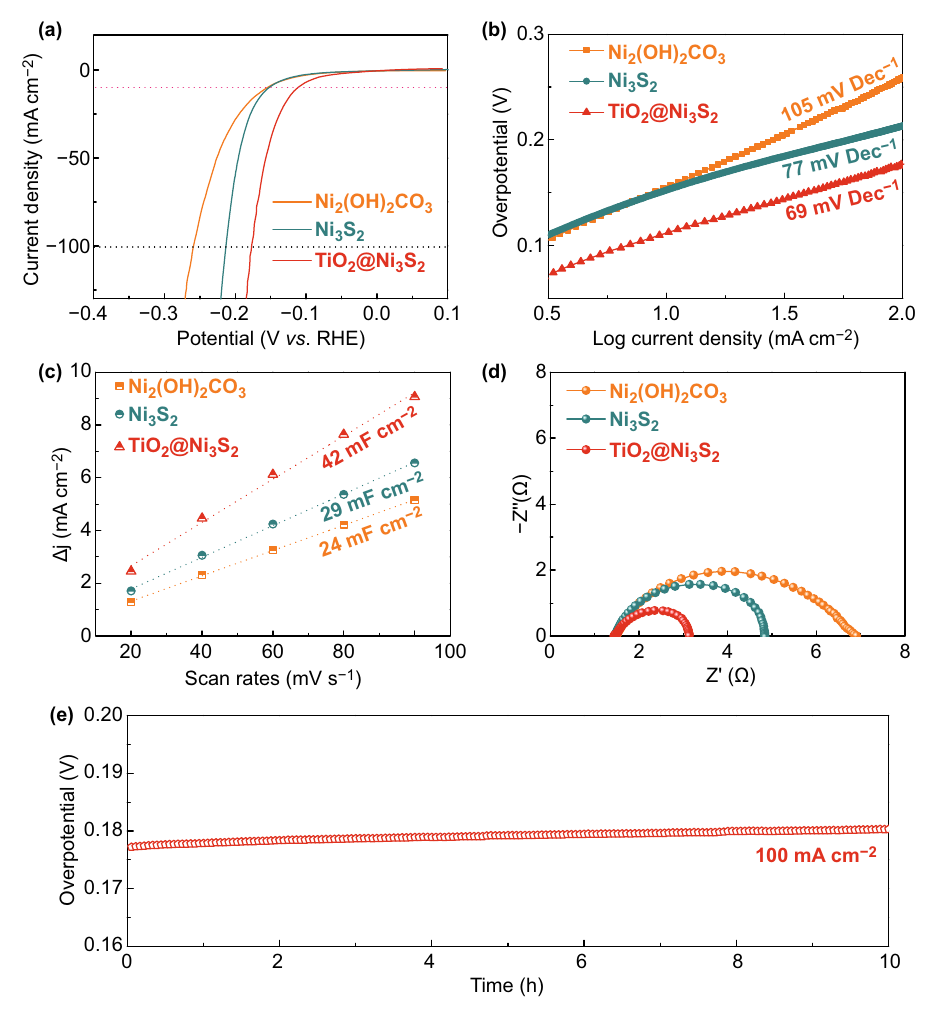
Fig. 4 Evaluation of the HER performance and comparison of Ni 2 (OH) 2 CO 3 , Ni 3 S 2 , and TiO 2 @Ni 3 S 2 electrodes: a LSV curves, b Tafel plots, c current density as a function of scan rate, and d Nyquist plots of the Ni 2 (OH) 2 CO 3 , Ni 3 S 2 , and TiO 2 @Ni 3 S 2 electrodes. e Electrochemical stabil- ity of the TiO 2 @Ni 3 S 2 electrode at a current density of 100 mA cm